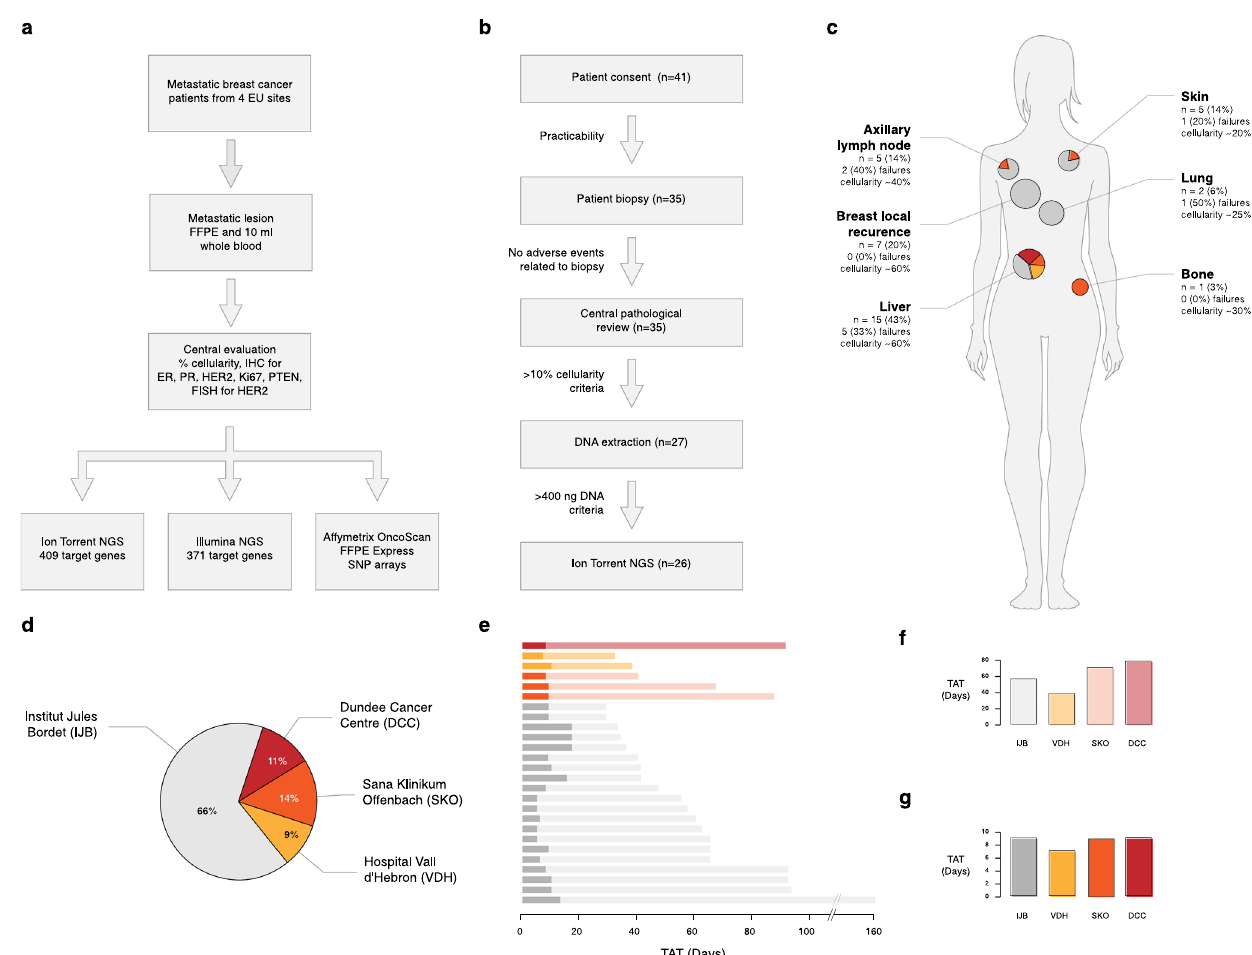
Fig. 1 Logistics and feasibility of the study. a logistic work fl ow of the study, b inclusion criteria and number of patients with successful results, c anatomical distribution of biopsied lesions with breakdown by recruiting centre, d global distribution of patients by recruiting centre, e turnaround time for each patient with breakdown by recruiting centre, f median global turnaround time by recruiting centre, and g median delivery turnaround time by recruiting centre. In a , the Illumina sequencing and Affymetrix OncoScan SNP arrays were done as batch processes. 19 patients were sequenced by Illumina targeted NGS and 18 patients were genotyped using the Affymetrix SNP arrays. However, these are not fully overlapping subsets and only 14 (54%) patients had the full set of all three data types. In a and b , the Ion Torrent sequencing results were obtained in real-time and in ( e ), the darker shades indicate delivery turnaround time (TAT) whilst the lighter shades indicate global turnaround time. The colour codes for the recruiting centres in c to g are indicated in ( d